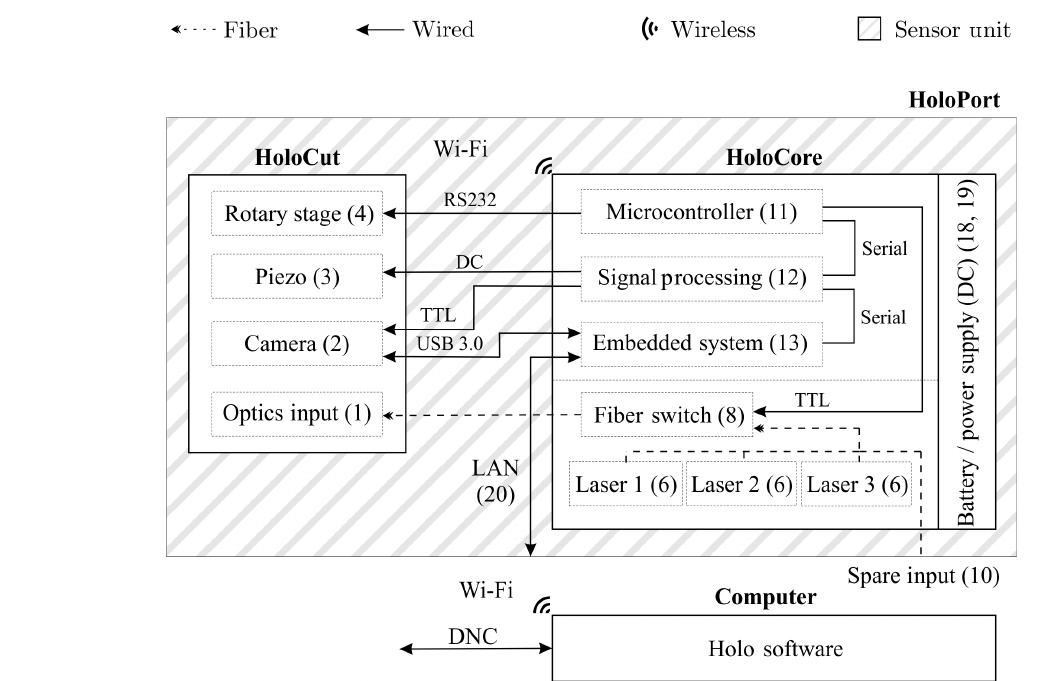
Figure 1. System architecture: equipped with the control module, the wired sensor head HoloCut becomes the fully integrated measuring system HoloPort and operates completely wirelessly. The label numbers used in this figure also correspond to the numbers used Figs. 2a, b and